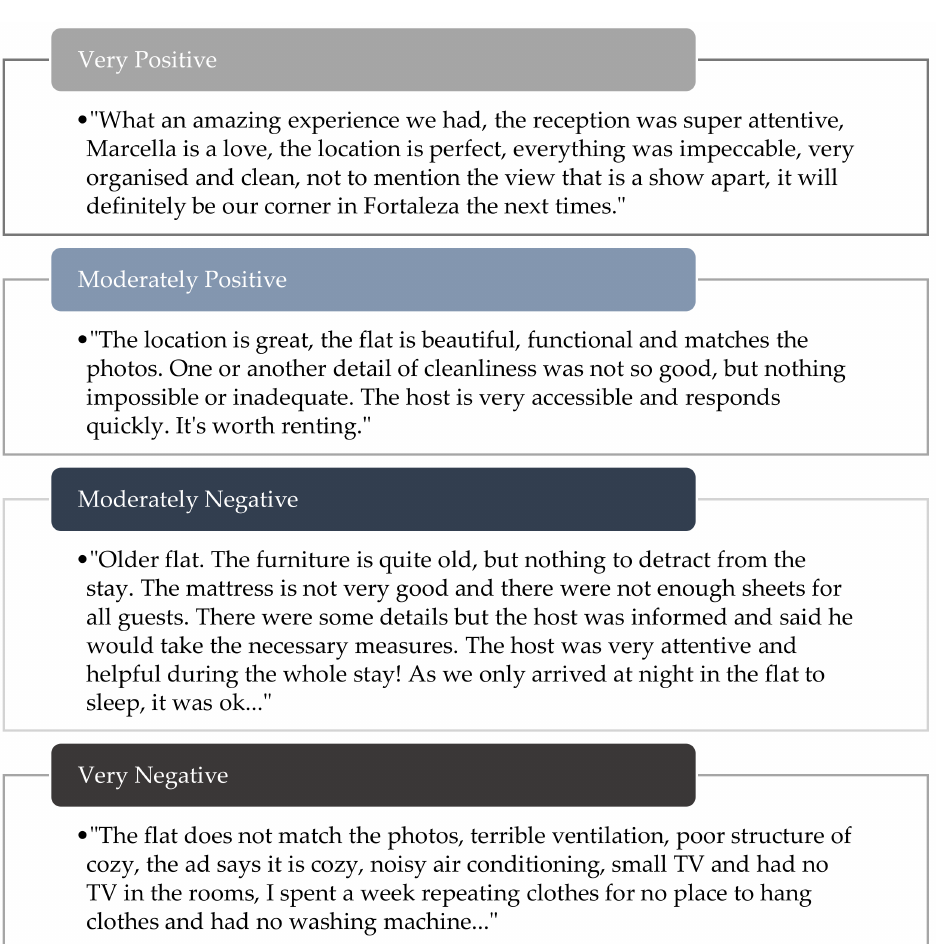
Figure 4. Examples of the identification of sentiment in Airbnb user reviews in